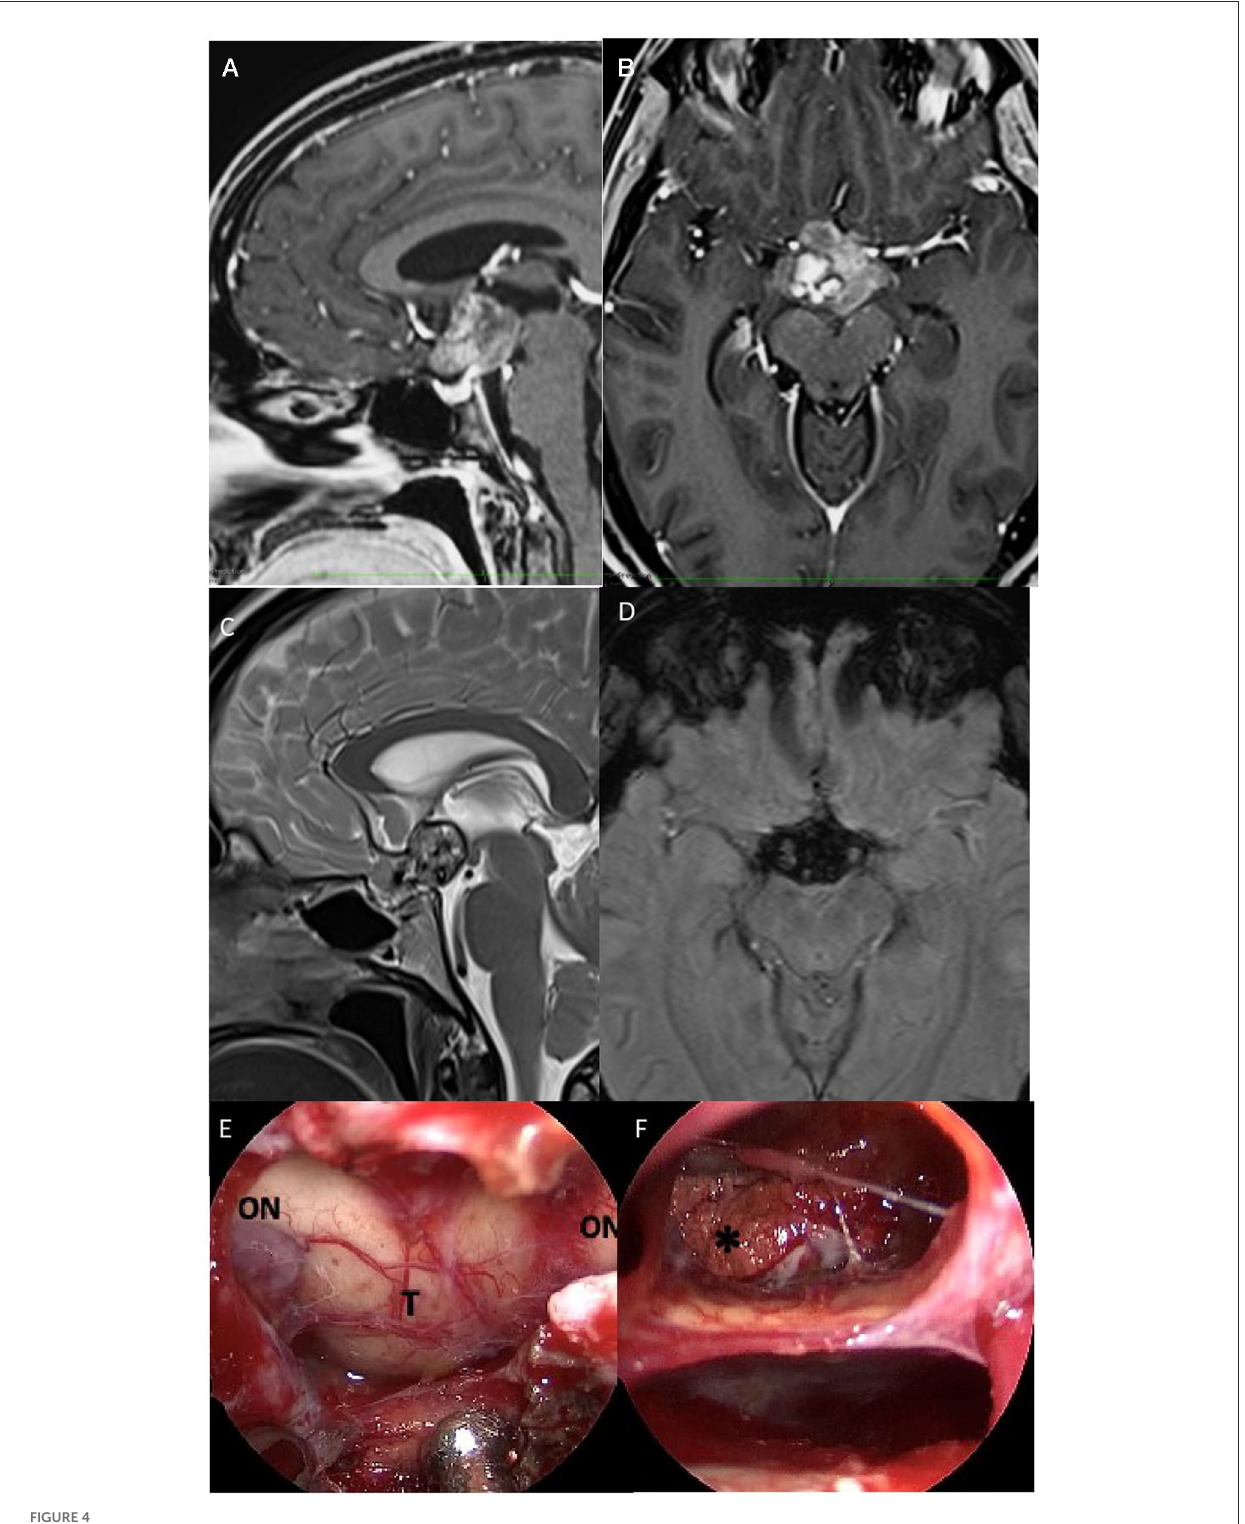
FIGURE4 Preoperative sagittal (A) axial (B) post-gadolinium, and sagittal (C) T2 MRI scan demonstrated a suprasellar mass with heterogenous low signal in T1 images and an intermediate high signal in T2 images, with cystic and calcific components of the lesion. Axial (D) susceptibility-weighted imaging (SWI) showed signal dropout (hypointensity) in the sellar region. The lesion measured ∼ 3 × 2,4 × 3, and 3cm on anteroposterior, cephalocaudal, and transverse dimensions. (E) After dura opening , the evacuation of the intralesional hemorrhagic component localized inside the optic chiasm and infundibulum of the third ventricle was performed, which appeared dislocated below; (F) at the end of the procedure, a yellowish granulomatous formation was removed in fragments of dubious vascularization but suspected of a possible, already site of previous bleeding and adhering to the ventricular walls. ON, optic nerve; T, tumor.